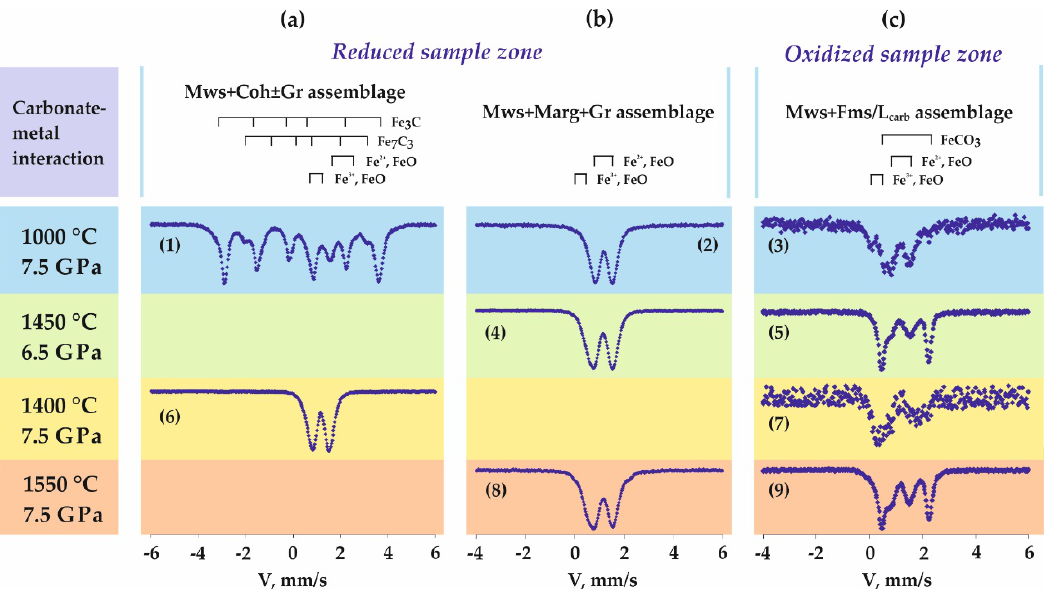
Figure 3. Scanning electron microscopy (SEM) photographs of sample fragments, which were produced in the carbonate-iron system: ( a ) graphite, cohenite and magnesiowüstite (reaction zone) at the contact between coarse-grained cohenite and a fine-grained magnesiowüstite + aragonite + graphite aggregate (1000 °C, 7.5 GPa); ( b ) assemblage of magnesiowüstite and cohenite (reduced zone) (1450 ° С , 6.5 GPa); ( c) crystals of magnesiowüstite and graphite in a quenched carbonate melt (1450 ° С , 6.5 GPa); ( d ) crystals of magnesiowüstite and graphite, with quenching carbonate in interstices (1450 ° С , 6.5 GPa); ( e , f ) diamond crystals and quenching carbonate in coarse-grained magnesiowüstite interstices (1550 ° С , 7.5 GPa). Coh: cohenite, Mws: magnesiowüstite, Arg: aragonite, Gr: graphite, Dm: diamond, L carb : predominantly carbonate melt.